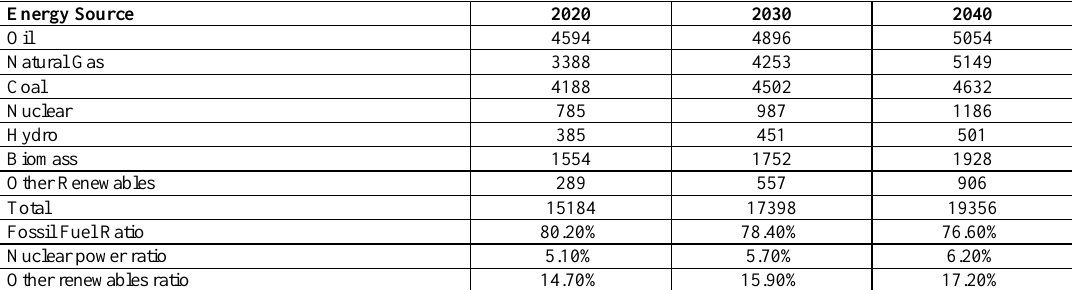
Table 2. Global energy demand forecasts until